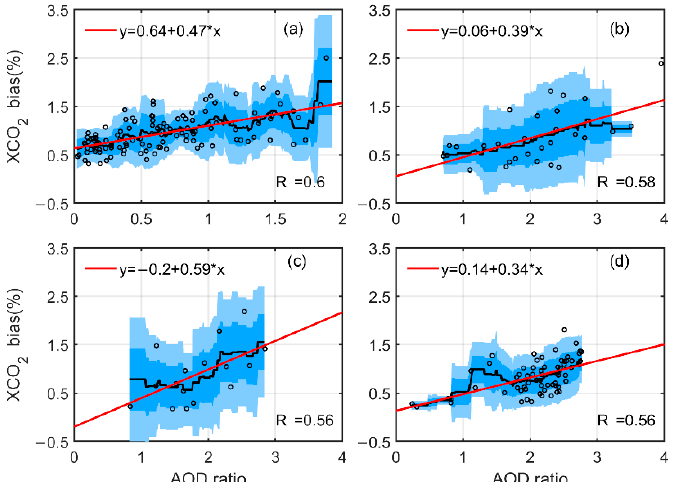
Figure 6. Correlation analysis between ∆ X CO 2 and τ 755/532 when τ 532 ≠ 0: ( a ) SON (0, 0.1] at Bialystok site; ( b ) MAM (0, 0.1] at Garmisch site; ( c ) MAM (0.1, 0.3] at Bialystok site; ( d ) JJA (0.1, 0.3] at Garmisch site. The blue shaded areas represent the standard error (1 σ and 2 σ ).